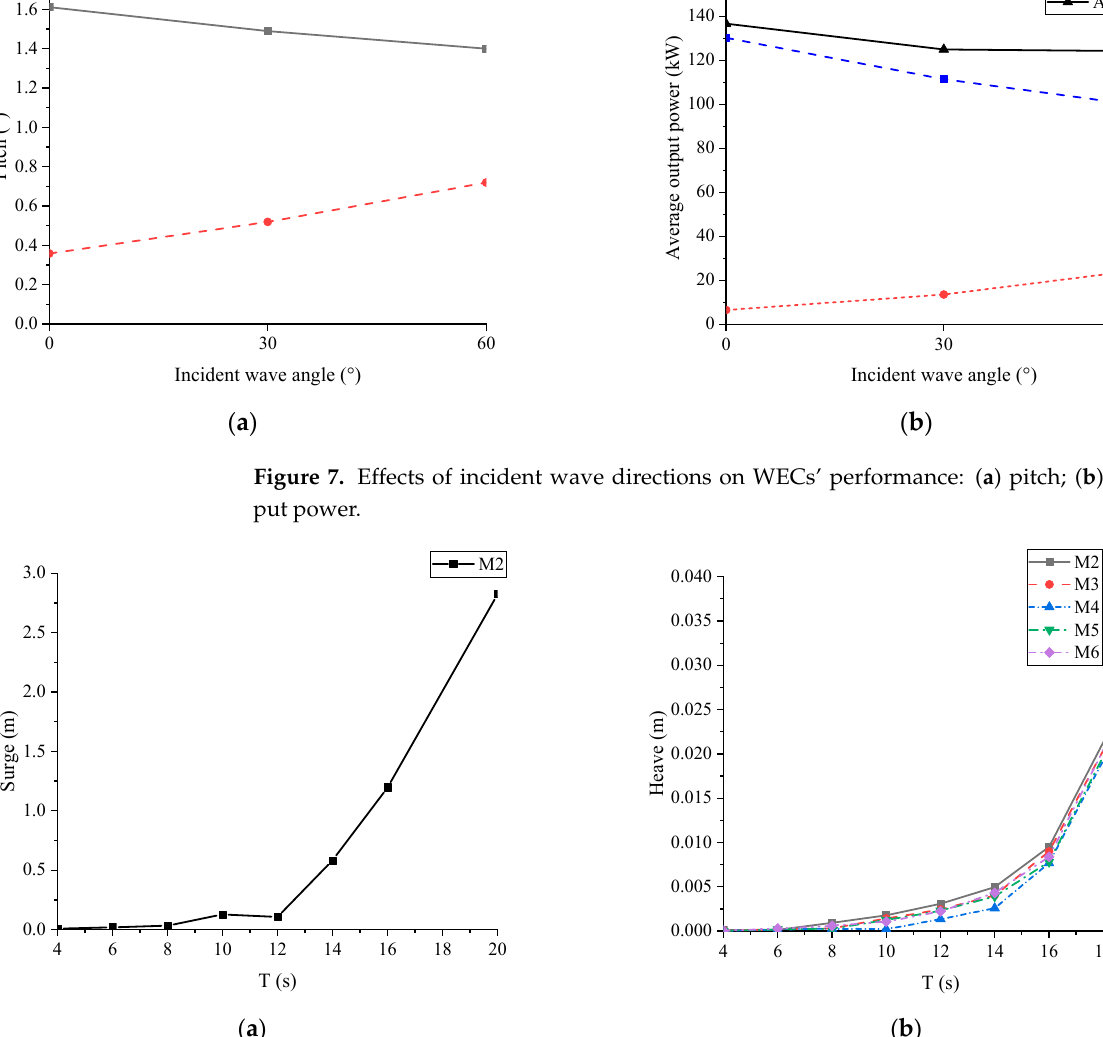
Figure 8. In Figure 8a,b, both the surge and the heave increased with the increase in the wave period. They gradually rose for the wave period less than 12 s, while they sharply rose for the wave period larger than 12 s. It indicates that both the surge and the heave of the MFS system are more sensitive to long-wave periods. In Figure 8c, the pitch responses of all hexagonal modules rose first and then gradually fell, reaching the peak for the wave period of about 12 s. The pitch peak phenomenon of each module was attributed to the module’s certain natural period. In addition, the pitch of the head-wave M2 was much larger than other hexagonal modules, due to less shielding effect. Figure 7. Effects of incident wave directions on WECs’ performance: ( a ) pitch; ( b ) average output power.